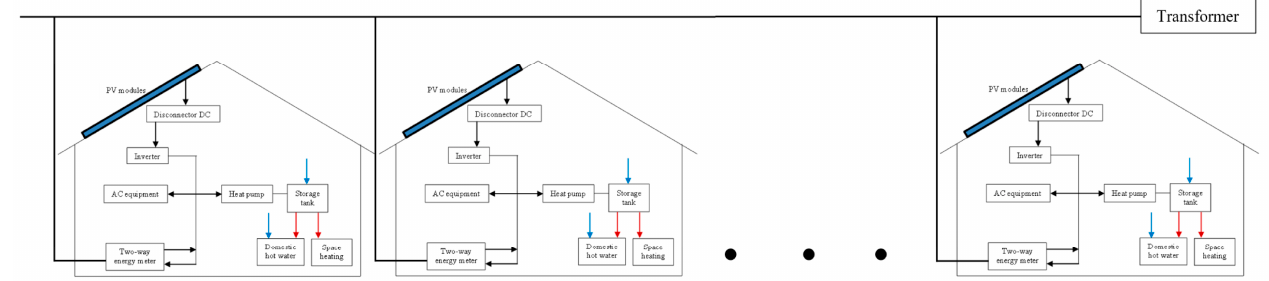
Figure 7. Schematic diagram of an example of a typical micro housing estate with individual energy system for every building of the estate.